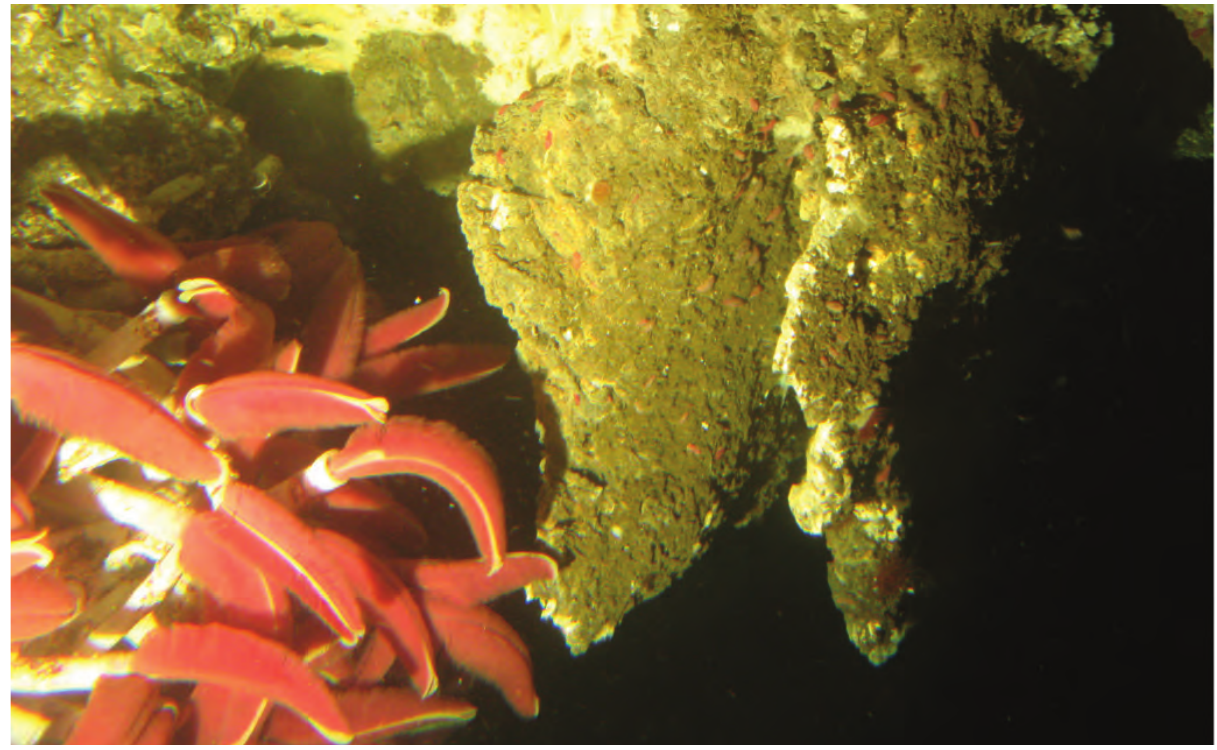
Riftia tubeworms on a hydrothermal vent chimney (2010 m deep at East Pacific Rise 9°50´N), which contains populations of symbiotic chemoauto trophic